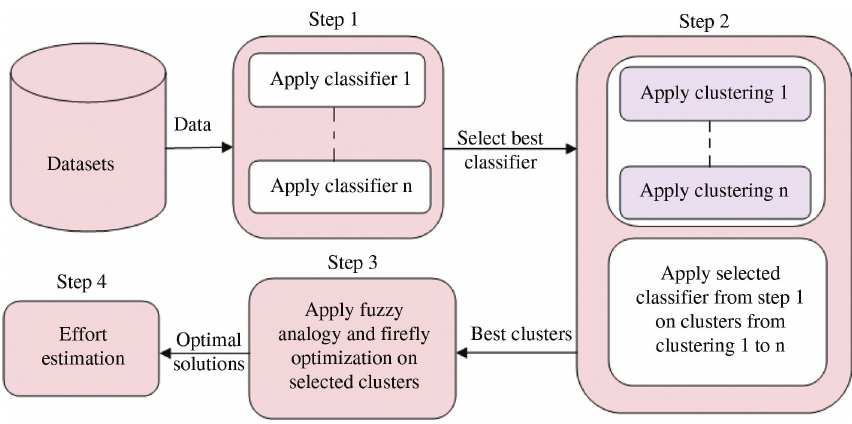
Figure 1: Proposed Learning Approach